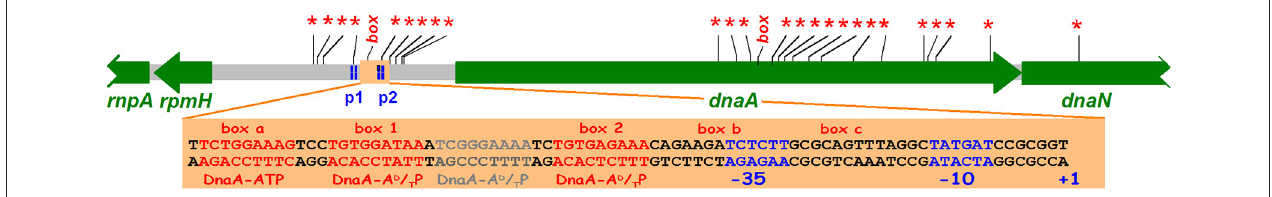
FIGURE 6 | The dnaA region with GATC sites (*) and consensus DnaA boxes (box). The position of dnaA promoters p1 and p2 are indicated (Hansen F. G. et al., 1982). The light orange rectangle shows the p2 promoter and potential DnaA boxes upstream of and overlapping the promoter. box1, box2 and the region in between are protected both by DnaA-ADP and DnaA-ATP, the boxes a, b, and c require DnaA-ATP (Speck et al., 1999). The CCGCGG sequence upstream of the + 1 position is a Travers box (Travers, 1980).